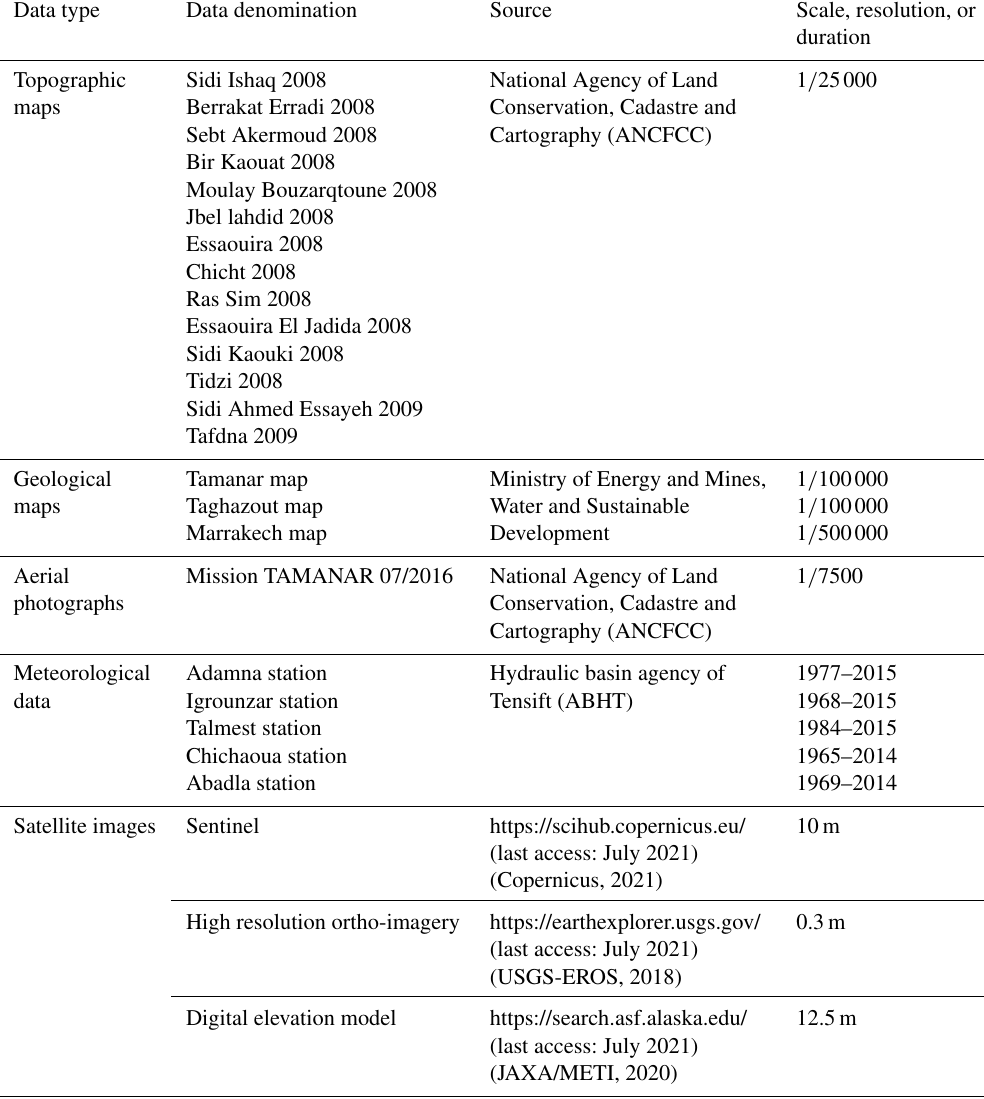
Table 1. Data sources